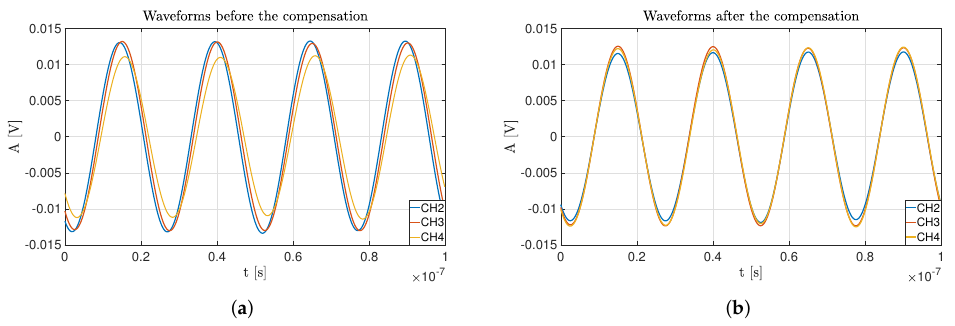
Figure 12. Time- domain comparison of the ( a ) acquired waveforms versus the ( b ) compensated waveforms in the Exp #2 calibration point. The initial waveforms were preprocessed through a digital FIR filtering and downconversion stage to the IF of 40 MHz for better view the